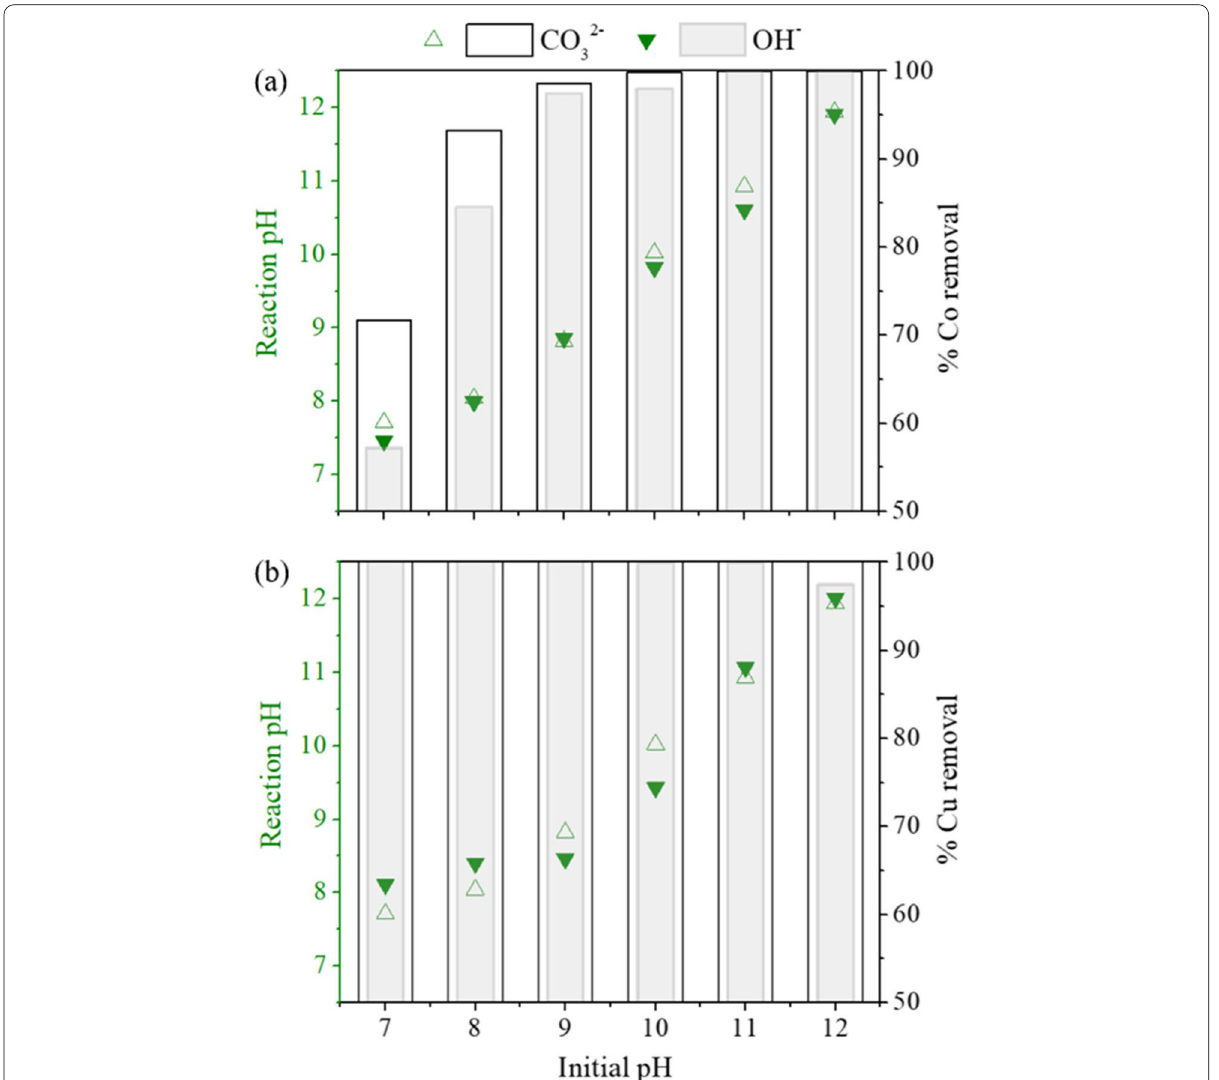
Fig. 4 Removal efficiency of ( a ) cobalt and ( b ) copper at different pH values using different precipitants ( Conditions: [Co] o pH variable; [P]/[M] = =